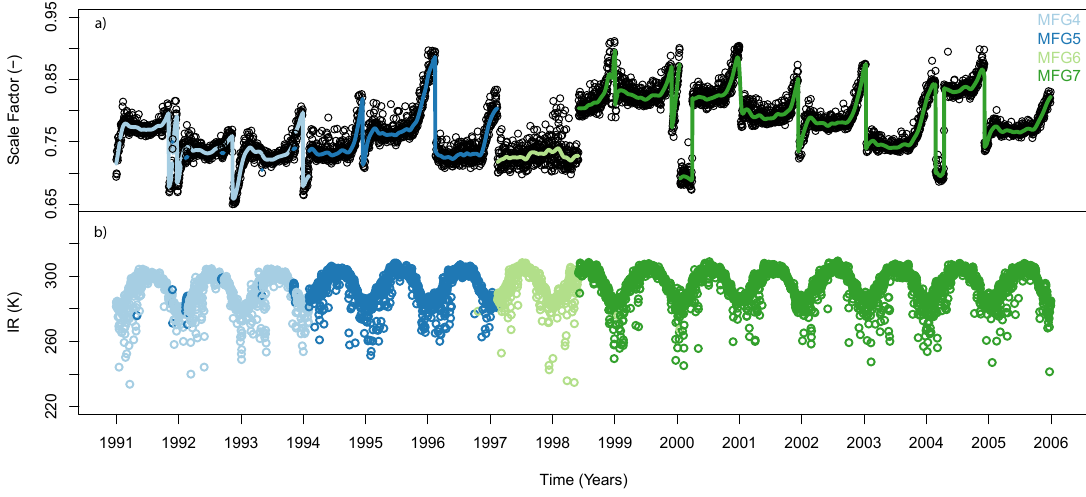
Figure 2. ( a ) High-resolution Infrared Radiation Sounder (HIRS) inter-calibrated digital number (count) to radiance scaling coefficients for Meteosat MVIRI (circles) and fitted ± 10-day Gaussian smoothing (lines). ( b ) Resulting all-sky brightness temperature time-series at the desert pixel over Egypt (Kharga synoptic observation site (SYNOP) with World Meteorological Organisation (WMO) number #62435